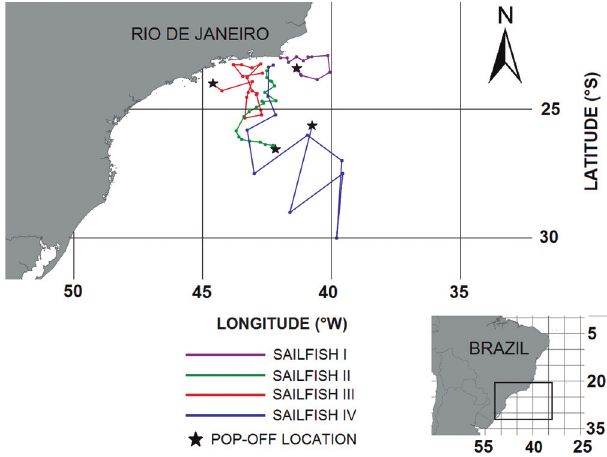
Fig. 4. Most-probable tracks for sailfish I, II, III, and IV fitted with Kalman Filter State-Space Model.